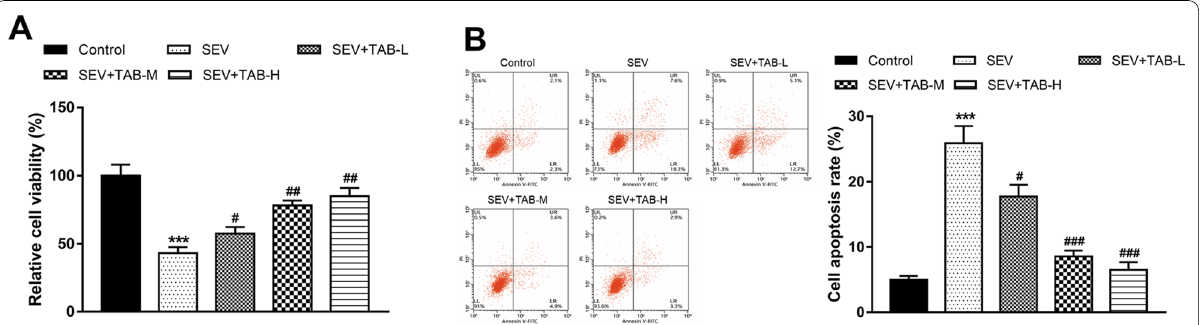
Fig. 2 Effects of TAB on PC12 cell viability and apoptosis. A PC12 cell viability was inhibited by sevoflurane, but this change was reversed by TAB treatment. B Sevoflurane promoted PC12 cell apoptosis, but TAB could significantly reduce the increased cell apoptosis rate induced by sevoflurane. *** P < 0.001 compared to normal group; # P < 0.05, ## P < 0.01, ### P < 0.001 compared to SEV group